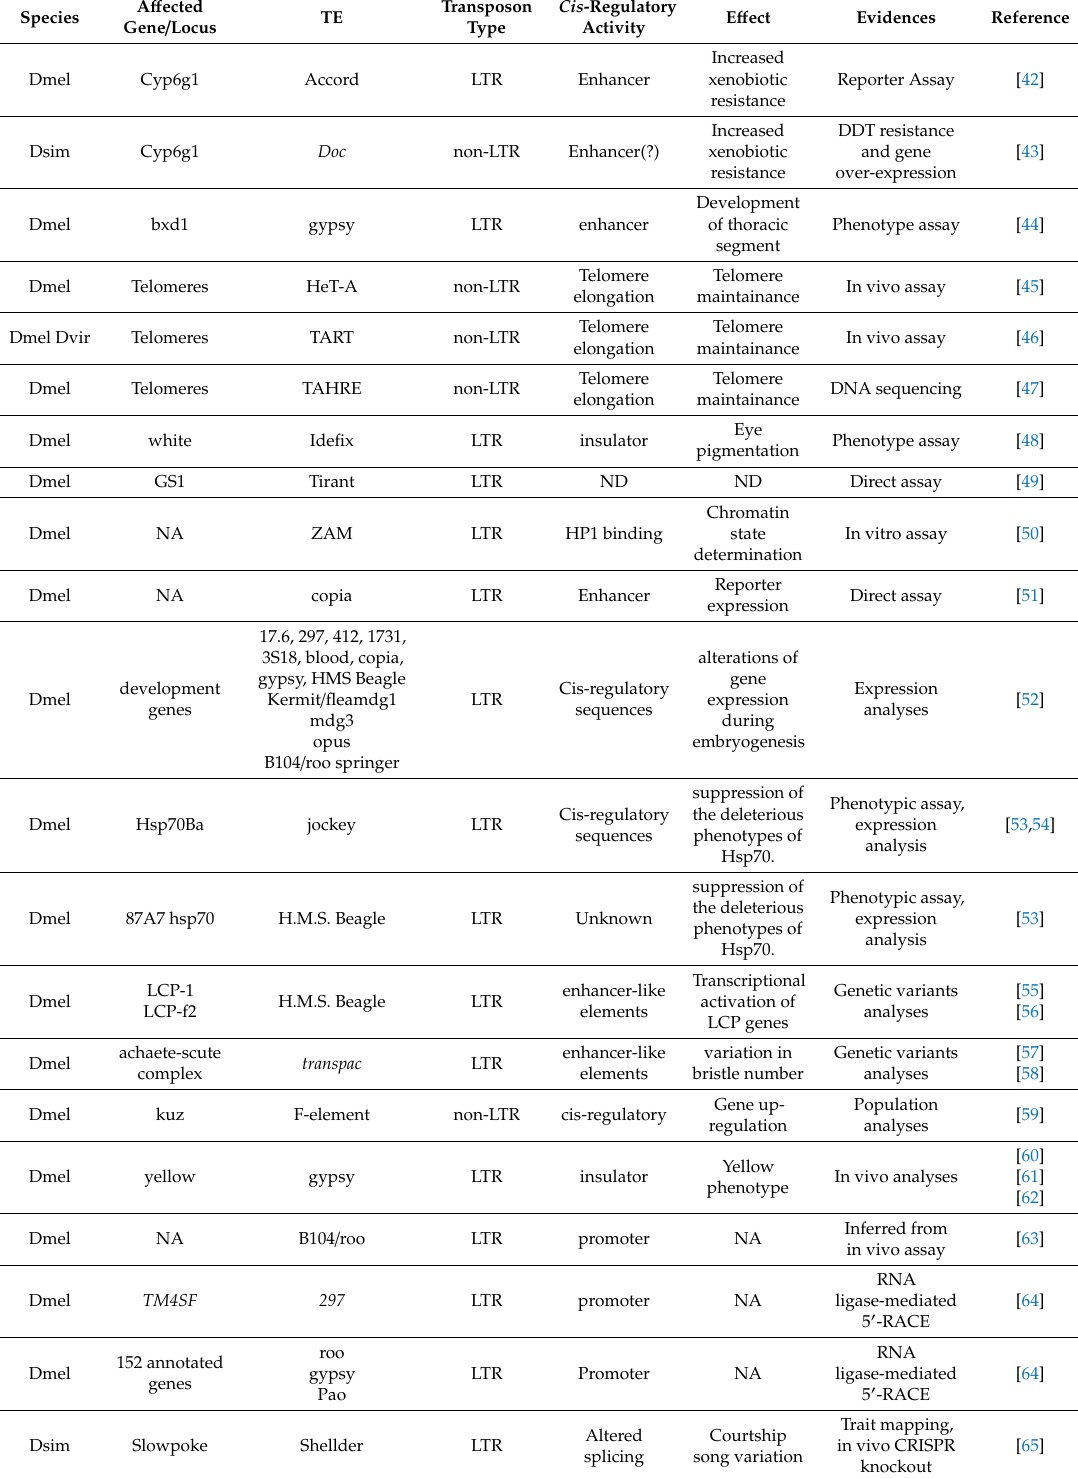
Table 1. List of reported cis -regulatory elements provided by TEs in Drosophila species. Species are indicated with a four-letter code (the first letter specifies the Genus, the following three specify the